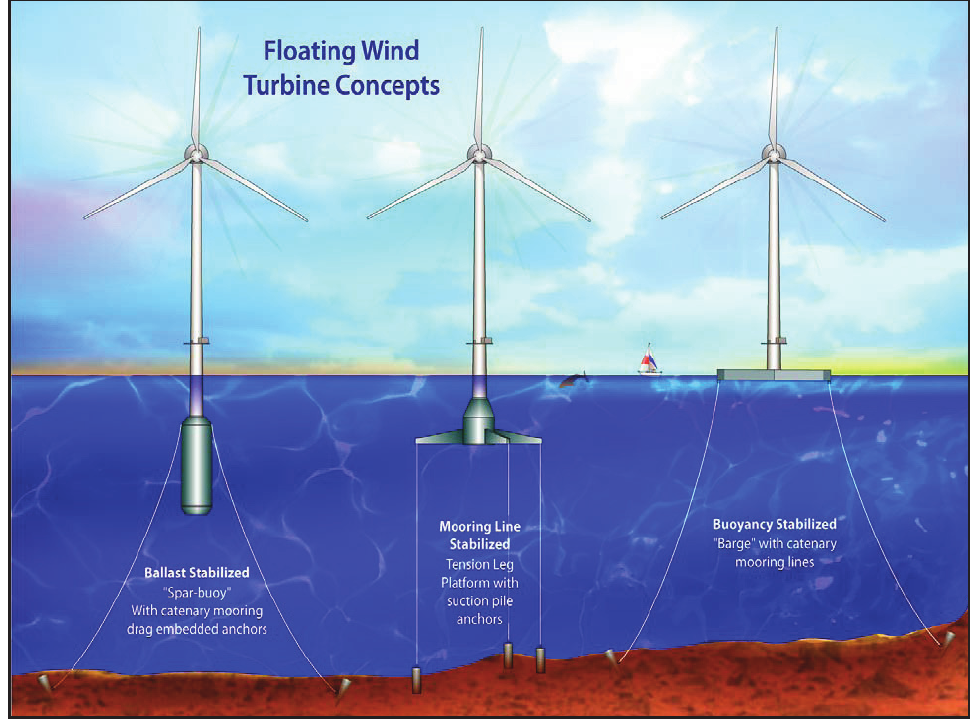
Figure 1-2. Floating platform concepts for offshore wind turbines Figure 1. Floating offshore wind turbine concepts